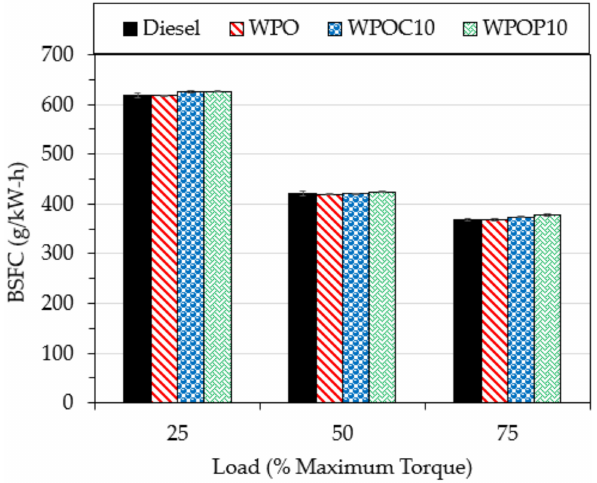
Figure 5. Variation of brake specific fuel